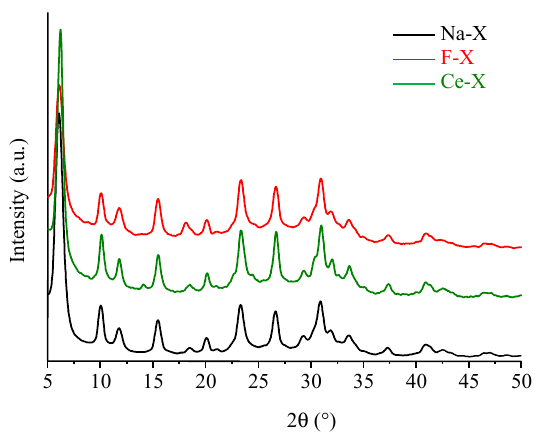
Figure 1. X-ray diffraction (XRD) patterns of as-synthesized Na-X, fluorinated F-X, and cerium ion exchanged Ce-X zeolites.